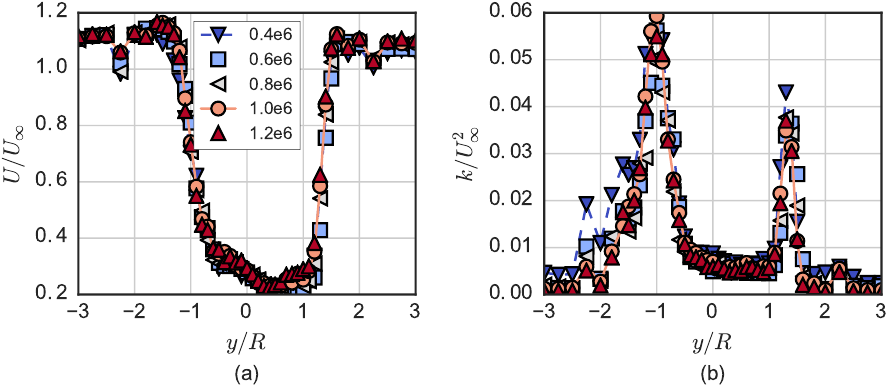
Figure 12. Mean streamwise velocity ( a ) and turbulence kinetic energy ( b ) profiles at z / H = 0.0. Turbine diameter Reynolds number Re D is indicated by the